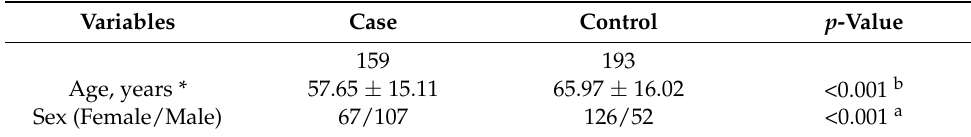
Table 1. Demographic variables for patients with gastric cancer and the control group. Variables Case Control